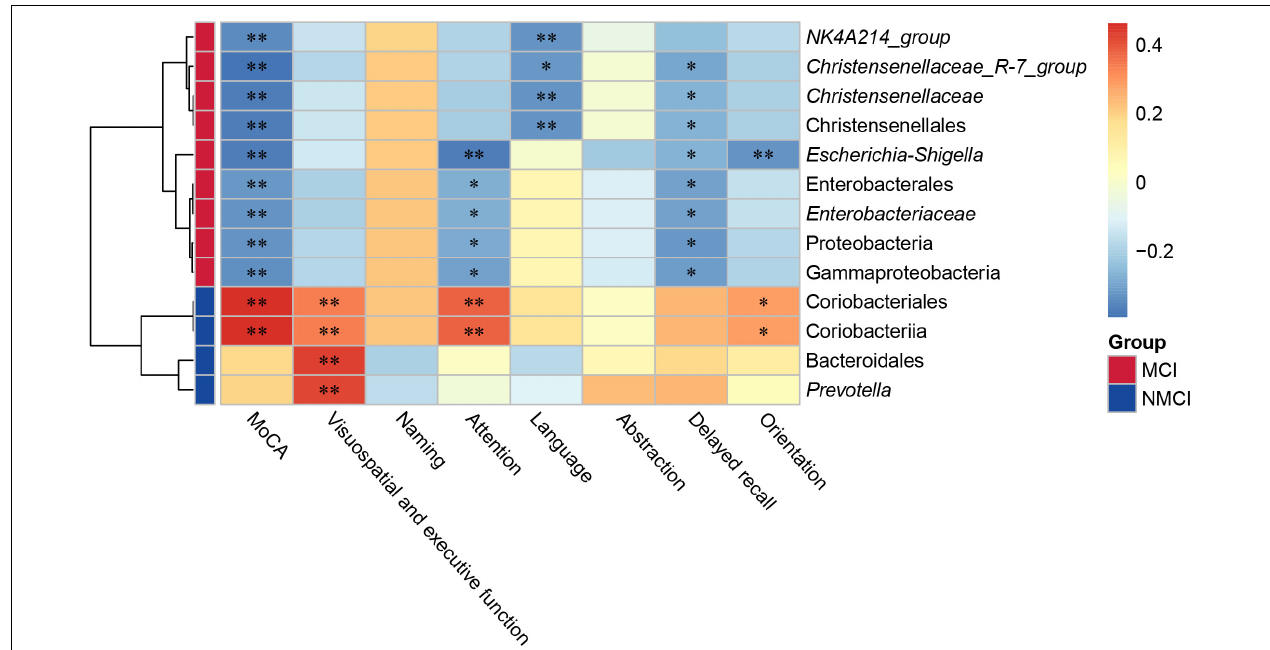
FIGURE 5 | Correlation analysis between gut microbial and MoCA score. The depth of the color in the heatmap represented the strength of the correlation: red represents a positive correlation, whereas blue indicates a negative correlation. Group scale represented enrichment of selected taxa, blue color indicates taxa enriched in the NMCI group, orange color represents taxa enriched in the MCI group. ∗ p < 0.05, ∗∗ p < 0.01. MCI, hypertension patients with cognitive impairment; NMCI, hypertension patients without cognitive impairment; Control, health control